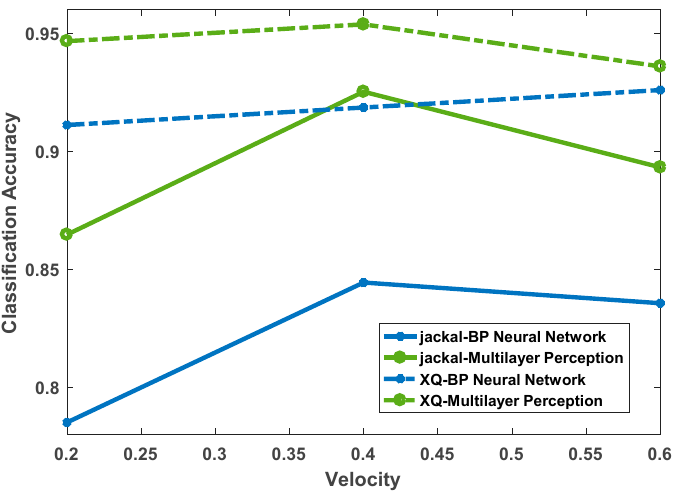
Figure 14. Classification accuracy of two algorithms at different speeds.